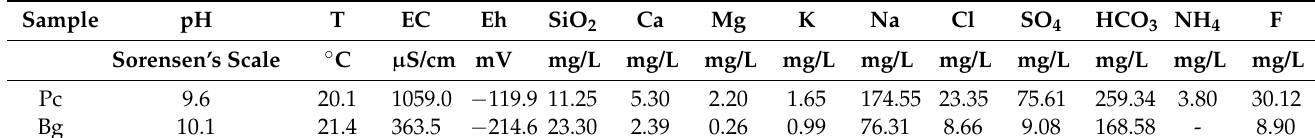
Table 2. Physical–chemical parameters of the studied groundwaters.